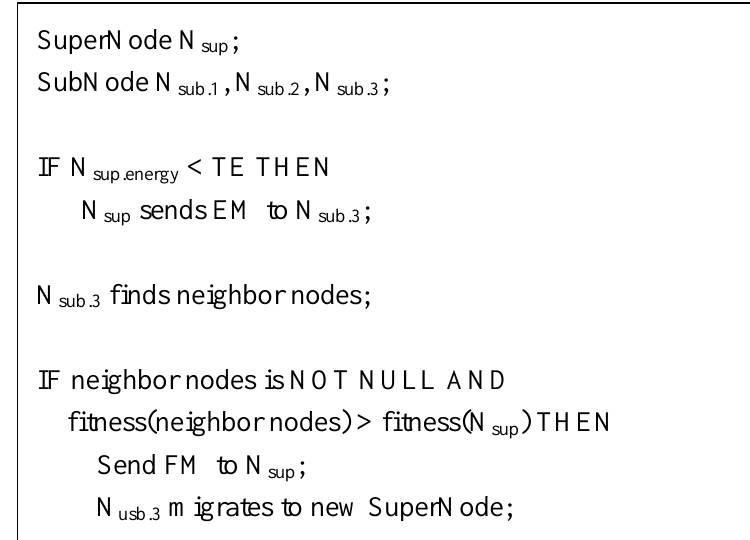
Table 1. Migration of